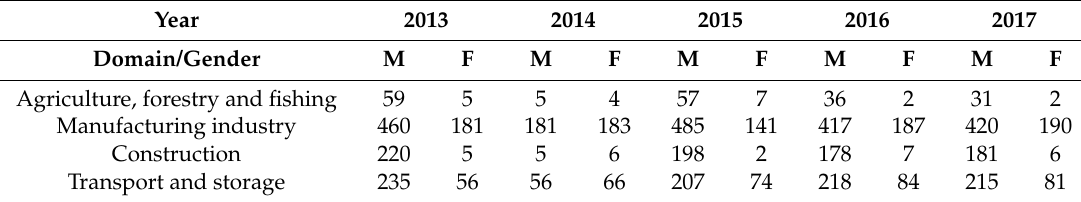
Table 3. The distribution of accidents in Bulgaria by gender [22].